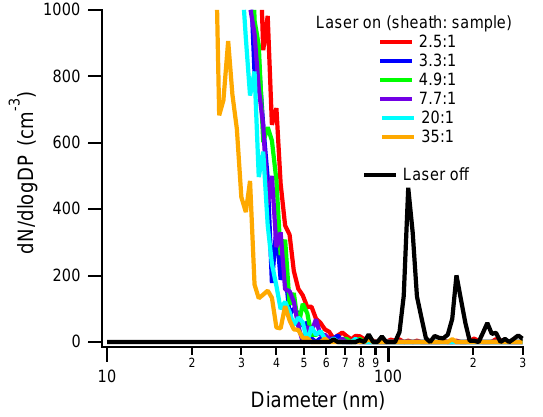
Figure 3. Size distribution of the SP2 exhaust from 125nm Aquadag ® particles at a concentration of 600cm − 3 under dif- ferent sheath-to-sample ratios. For reference, the size distribu- tion of a 125nm Aquadag ® particle at a sheath-to-sample ratio of 4.9:1 is shown in black. The absolute SP2 laser power was 1290nW / (220nmPSL).